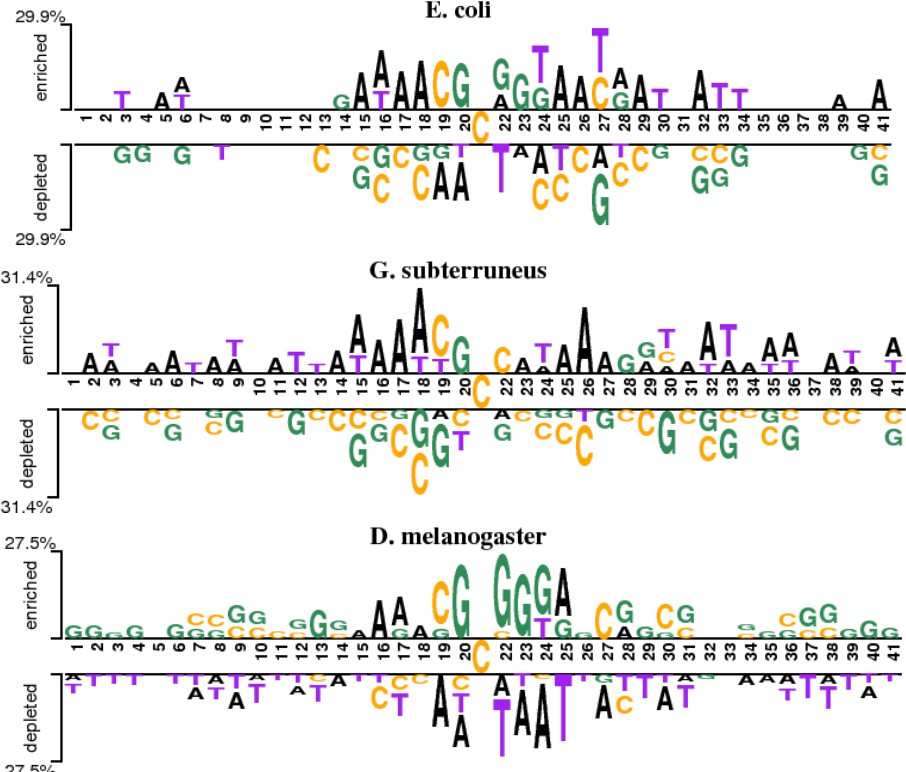
Figure 2. Sequence logos between 4mC sites and non-4mC sites of Escherichia coli , Geoalkalibacter subterraneus, and Drosophila melanogaster